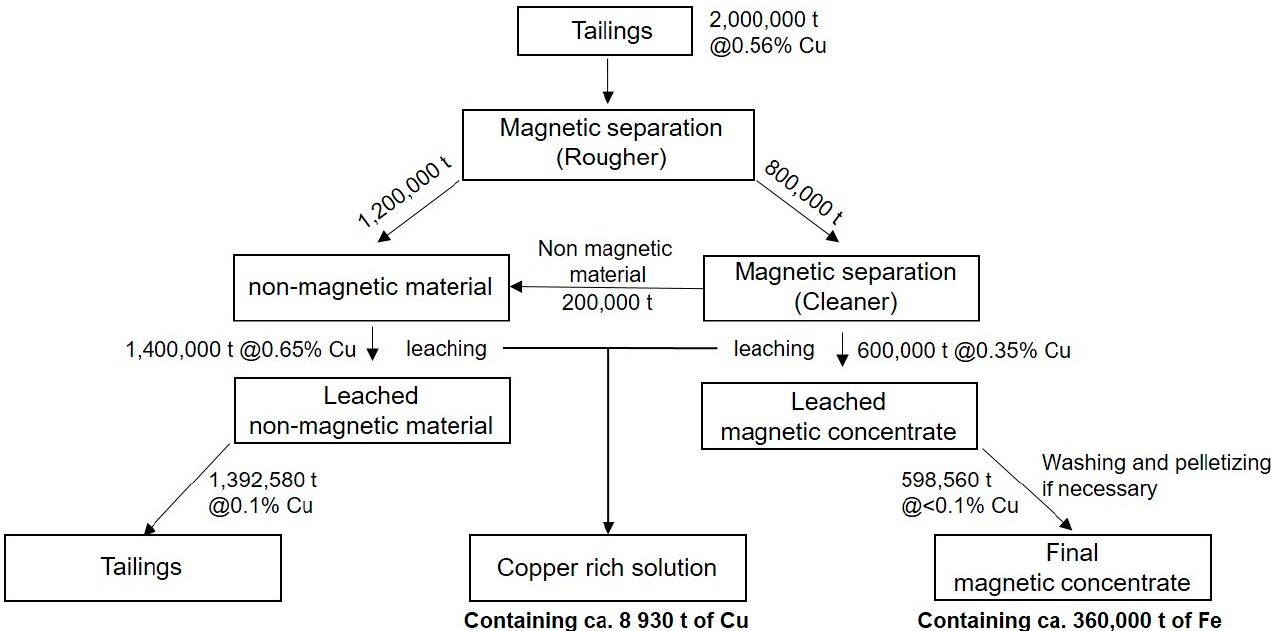
Figure 9. Recoveries (crosses) and leached copper grade (filled symbols) of the original tailings material (Org) and the two fractions with the ferromagnetic material (FM) and the non-magnetic material (NFM). The leached copper is given as % of the solids. The leaching seems to begin at time 0; it is actually 5 min after t 0.